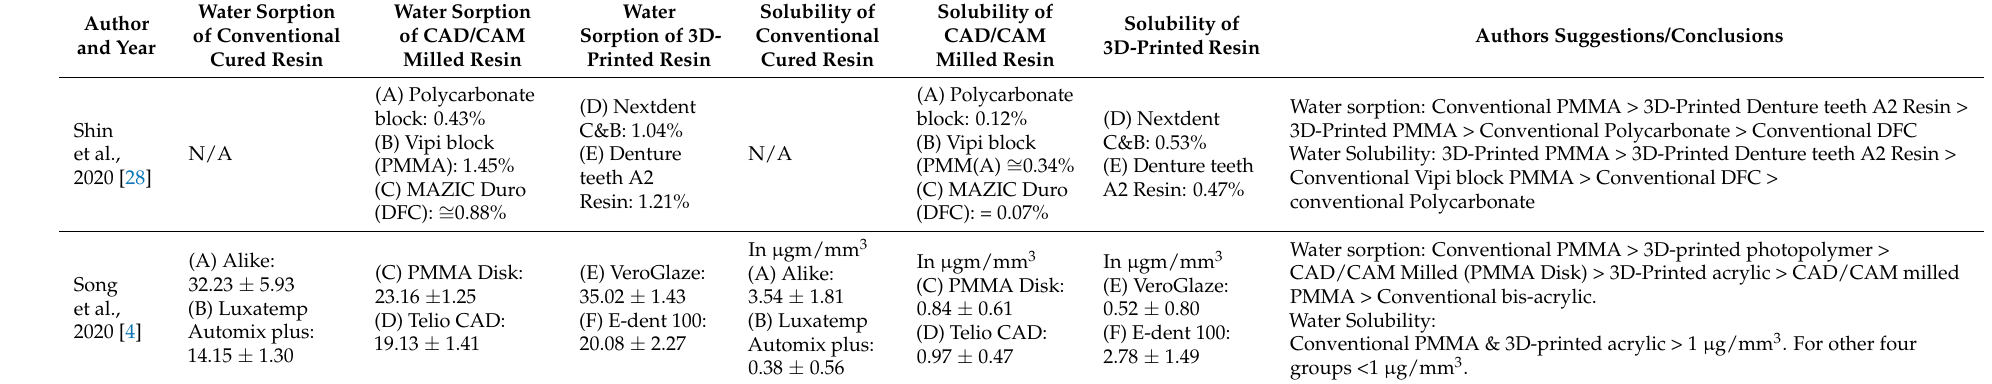
Table 6. Water sorption and solubility Results.